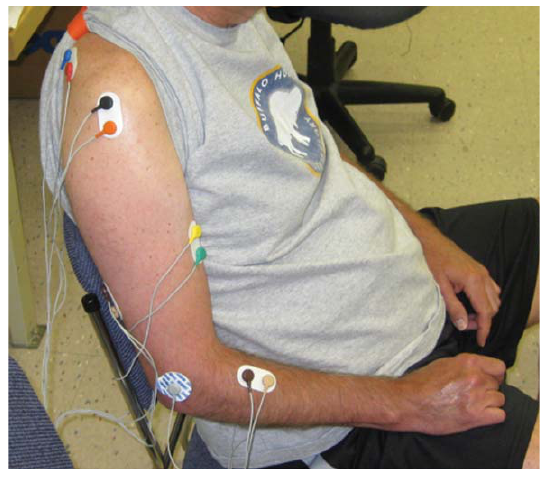
Fig. 13. Displayed here is the EMG channel placement for the CCS subjectforthethreeDOFmyoelectriccontrolschemewhichincludes wrist extensors and flexors, biceps, triceps, deltoid, and